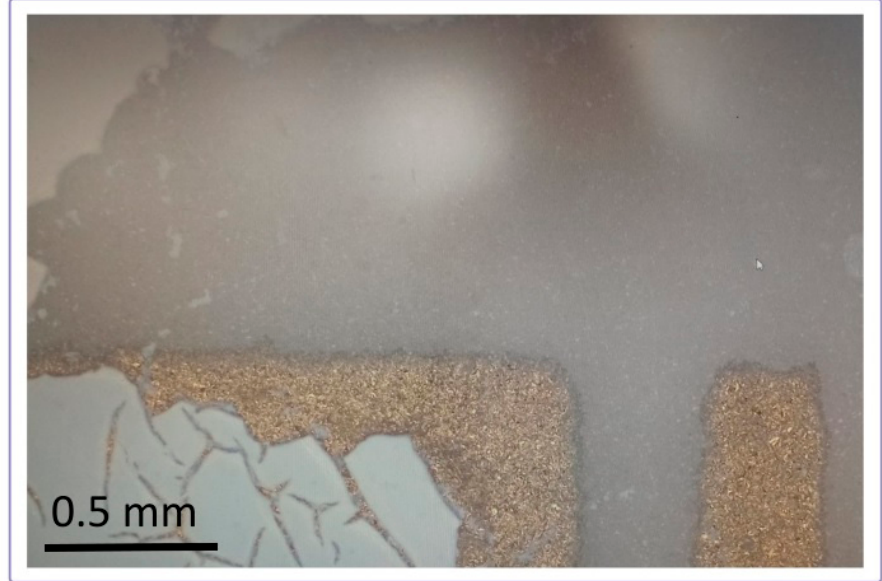
The thick film of mixtures and CeO 2 exhibited good attachment to the alumina sub-